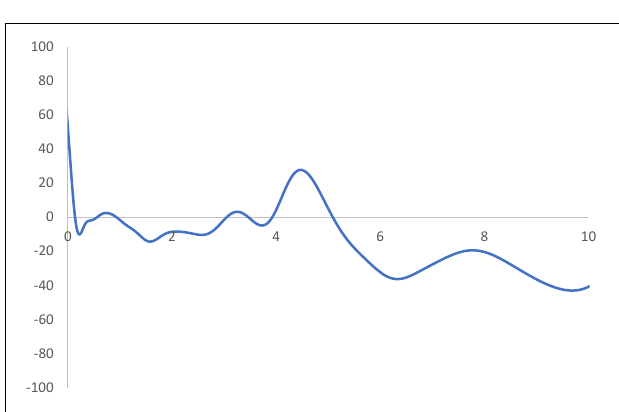
FIGURE 6 | Mobility probability plot (MPP) for the RSVAPC of all countries. Source: Authors’ calculation. N.B. The vertical axis indicates net upward mobility (%) and the horizontal axis indicates RSVAPC